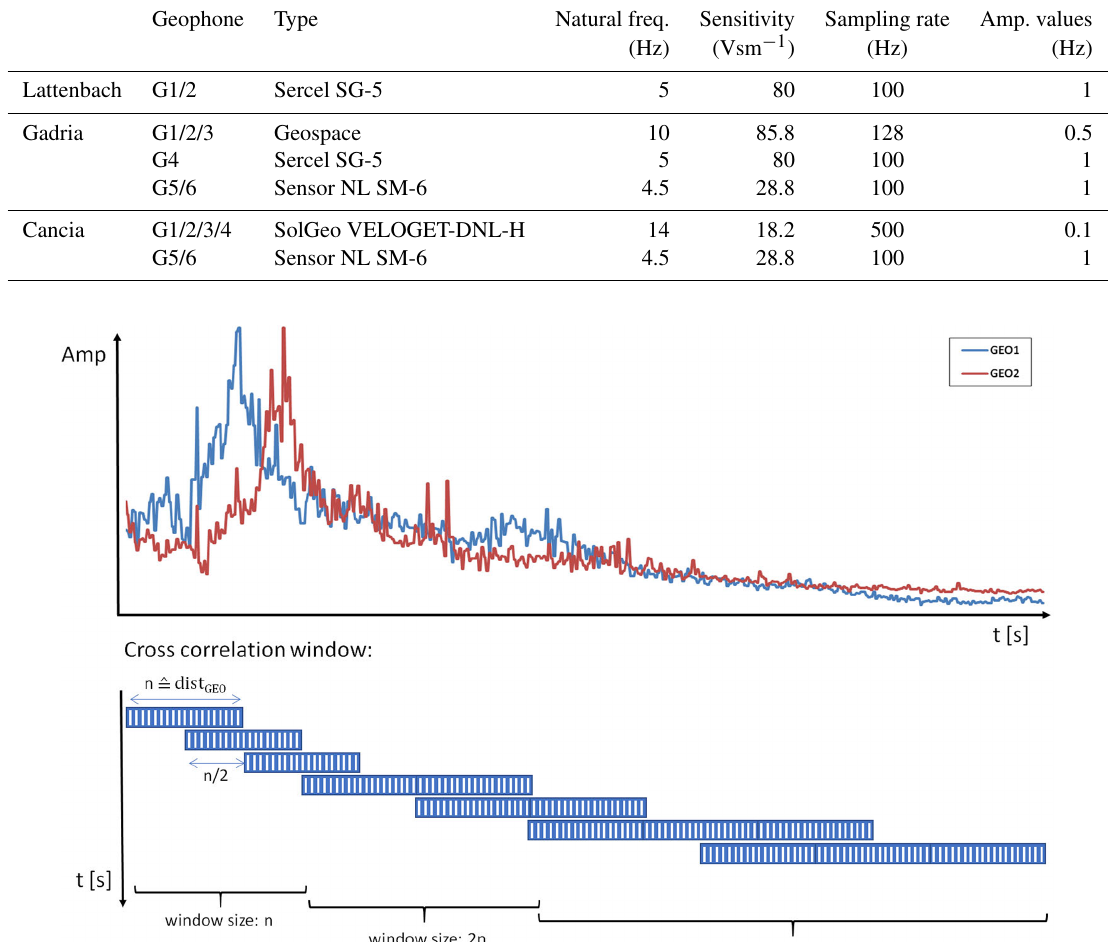
Table 1. Summary of the seismic monitoring equipment.